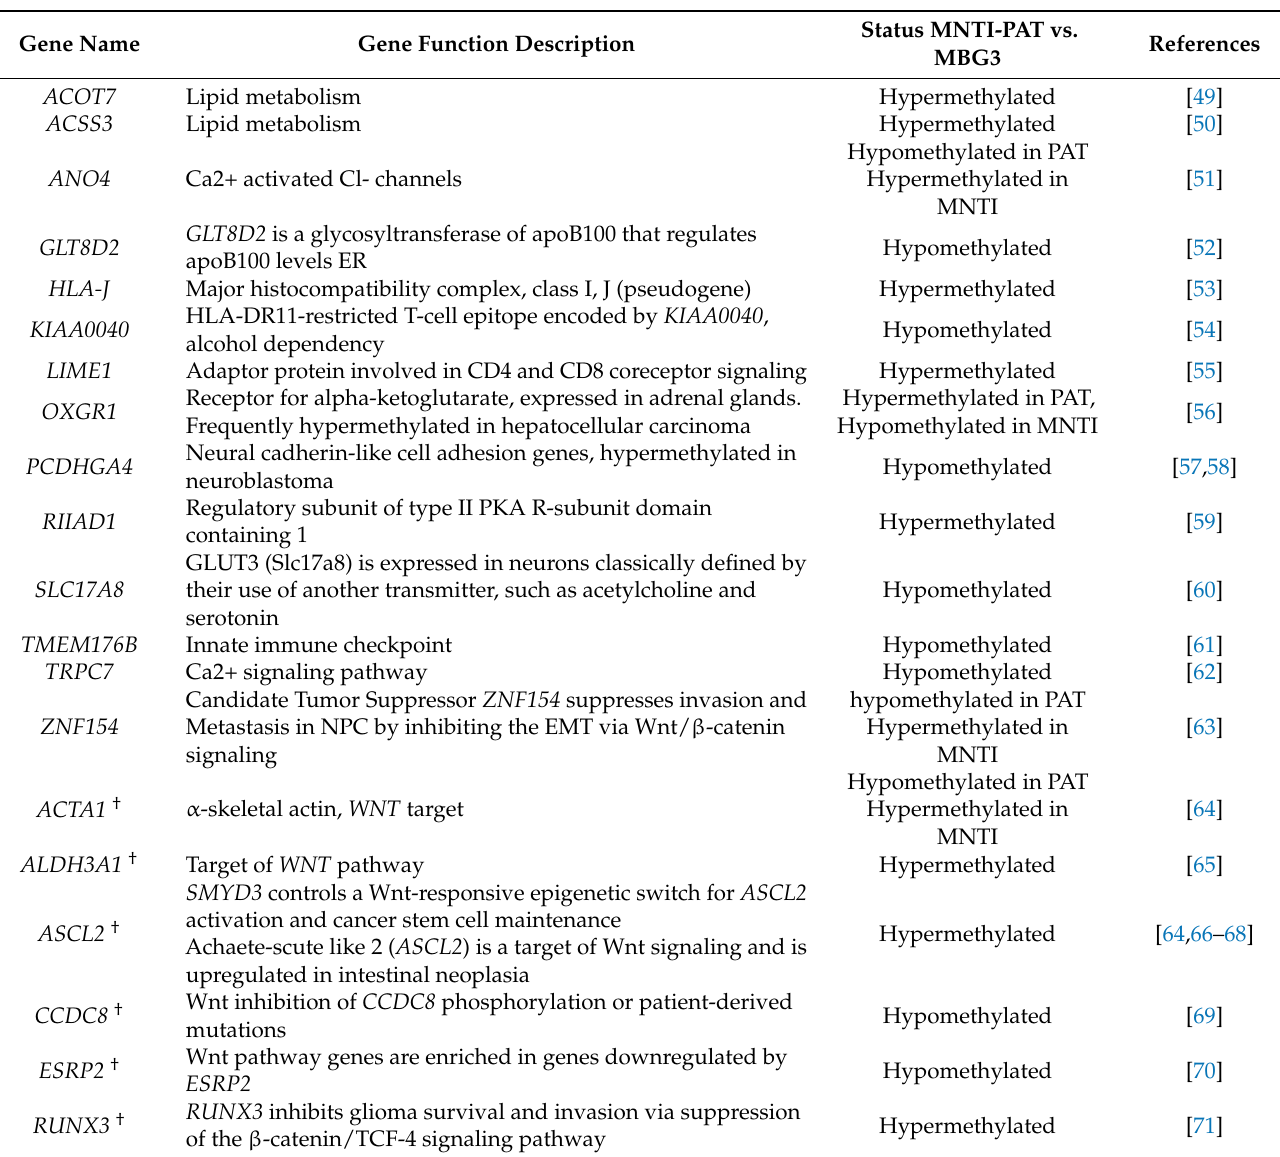
Table 2. Differentially methylated genes and their relationship with MNTI and